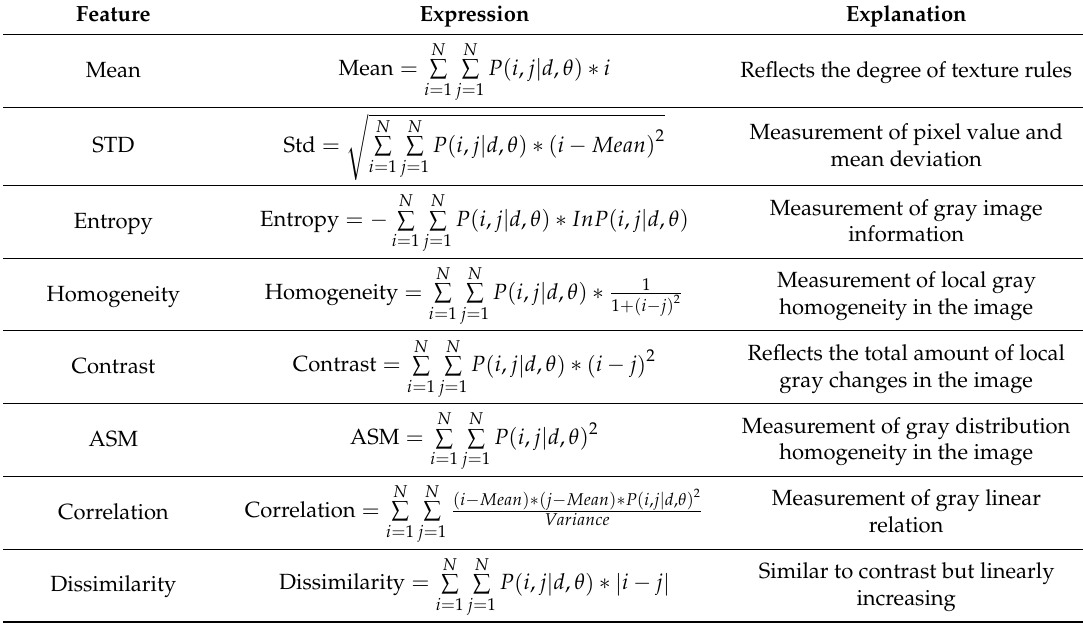
Table 2. Expressions and explanations of multibeam echo sounding (MBES) features. STD, standard deviation. ASM, angular second